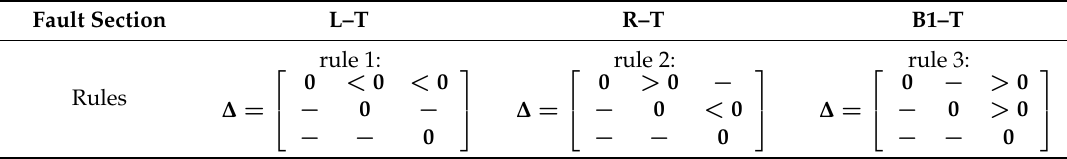
Table 1. Rules to identify fault section.